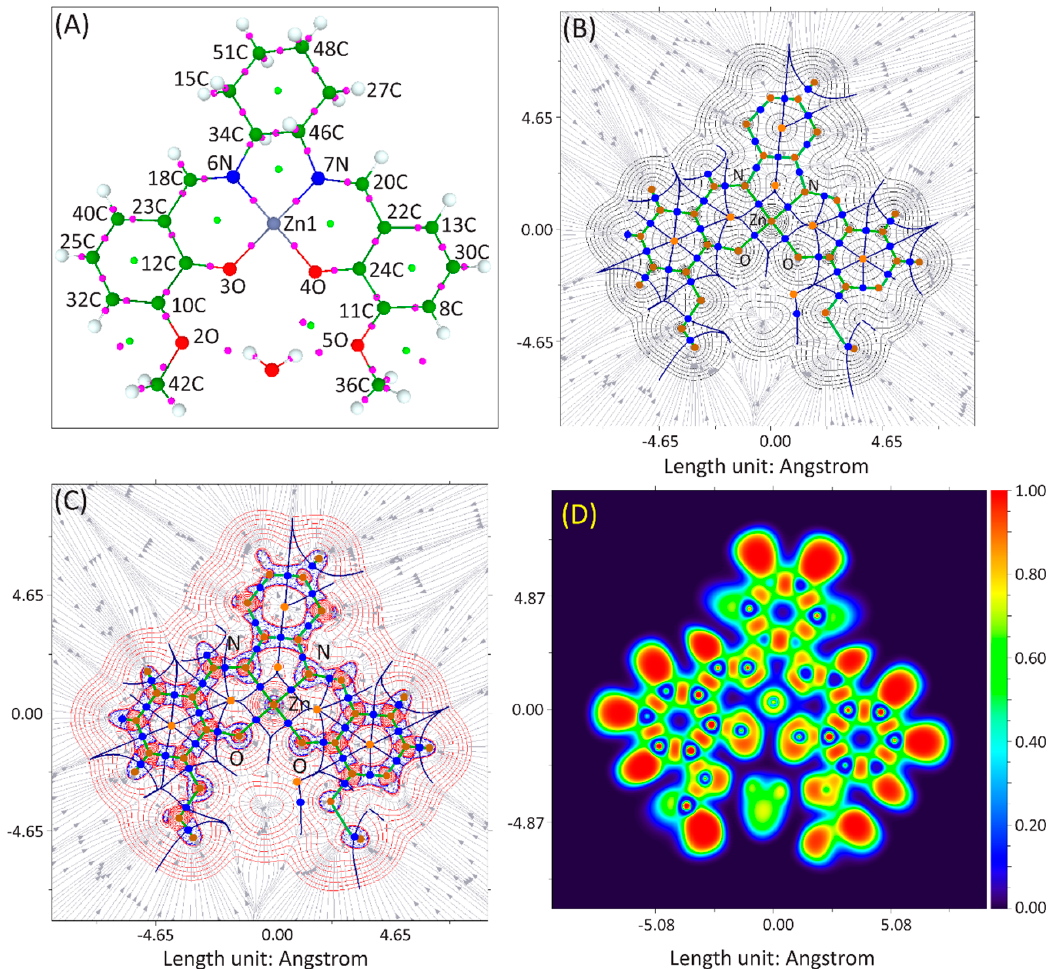
Figure 6. Quantum theory of atoms in molecule (QTAIM analysis) [Zn(sal)](H 2 O) (monomeric form): ( A ) molecular graph, showing the bond path and electron density ( ρ ) at bond critical points (BCPs). Purple circles indicate BCPs, and light green circles represent RCPs. ( B ) Contour line plots of the electron density ρ , ( C ) contour line plots of the Laplacian of electron density ∇ 2 ρ (r), the solid (red) and dashed (blue) lines corresponds to positive and negative values of ∇ 2 ρ (r) respectively, ( D ) surface maps of electron localization function (ELF). Bond paths are shown as black lines, selected zero-flux surfaces or interbasin paths as blue lines, bond critical points, BCPs (3, − 1) are shown in blue.